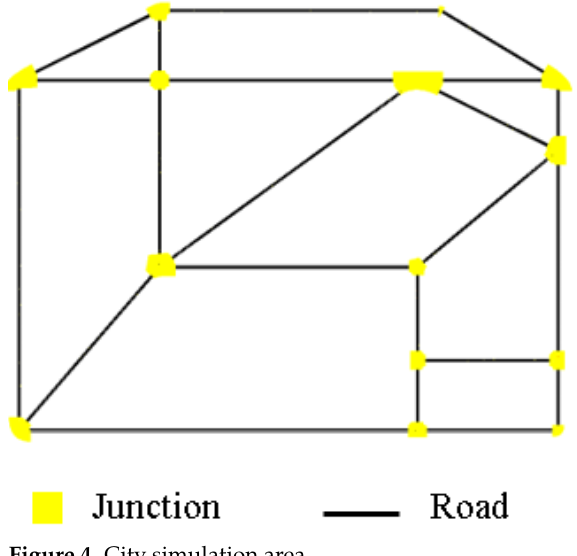
Figure 4. City simulation area.